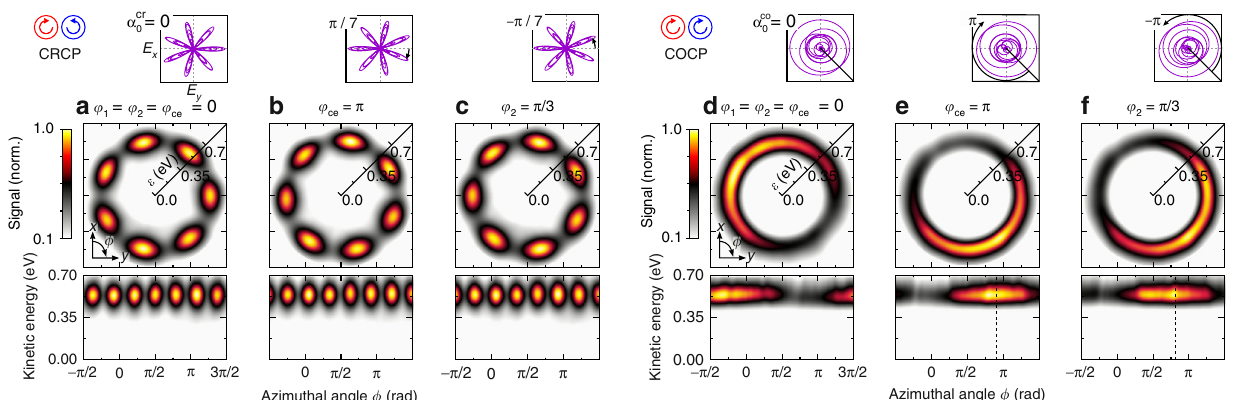
Fig. 4 Phase control of FEWPs from bichromatic MPI with CRCP and COCP (3 ω :4 ω ) pulses. Energy-calibrated central x - y -sections of the reconstructed PMDs for different values of the CEP φ ce and the relative phase φ 2 in cartesian (upper panels) and polar (lower panels) representation. Zero phase results from Fig. 3 are shown in a , d for comparison. b Variation of the CEP to φ ce = π rotates the propeller-type CRCP fi eld (see inset) and the corresponding ¼ π = 7 about the laser propagation direction. The same rotation, albeit in opposite direction, is induced by the relative phase φ FEWP by α cr 0 blue fi eld, leading to the same shape of fi eld and FEWP in c . In the COCP case, a CEP variation to φ ce = π rotates the heart-shaped pulse by α co crescent-shaped FEWP follows the fi eld rotation, as shown in e . f An equivalent rotation in opposite direction is induced by the relative phase of φ 2 = π /3. The center of the azimuthal lobes, indicated by vertical lines in the bottom frames, were derived from sinusoidal fi ts presented in Supplementary Note